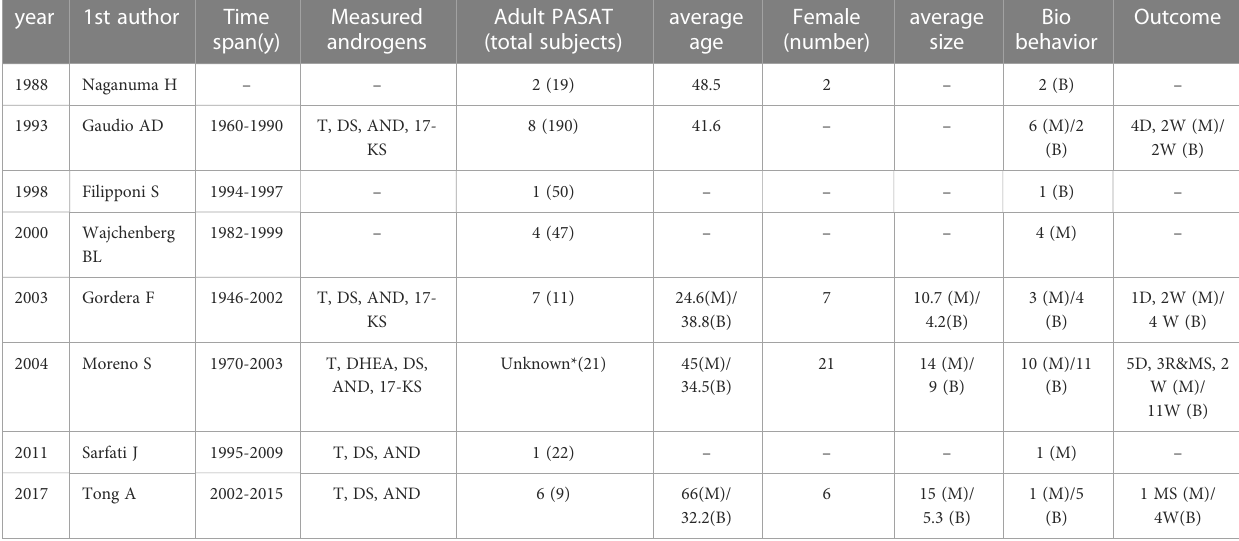
T,testosterone; AND,androstenedione; DHEA,dehydroepiandrosterone; DS, dehydroepiandrosterone sulfate;17-KS; 17-ketosteroid;R,reoccurrence, M,malignantgroup;Bbenign group;MS, metastasis; W, well (no recurrence or metastasis observed in the following time or till